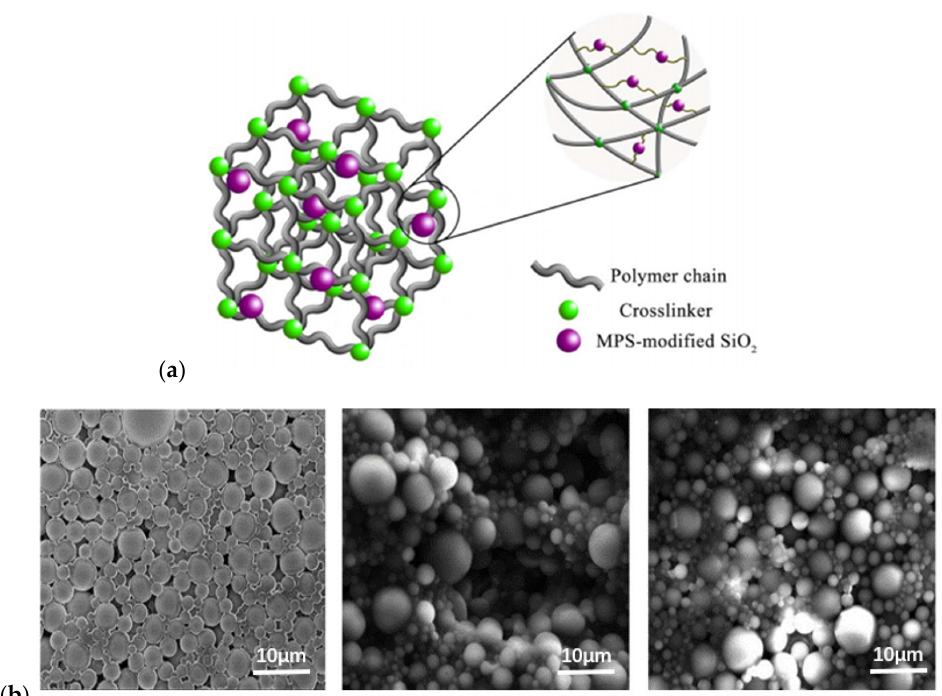
Figure 7. Structure diagram of polymer gel microspheres: ( a ) structure of silica-reinforced polymer microspheres and ( b ) microstructure of polymer microspheres. (Reprinted/adapted with permission from Ref. [49], 2018, Tang et al.).